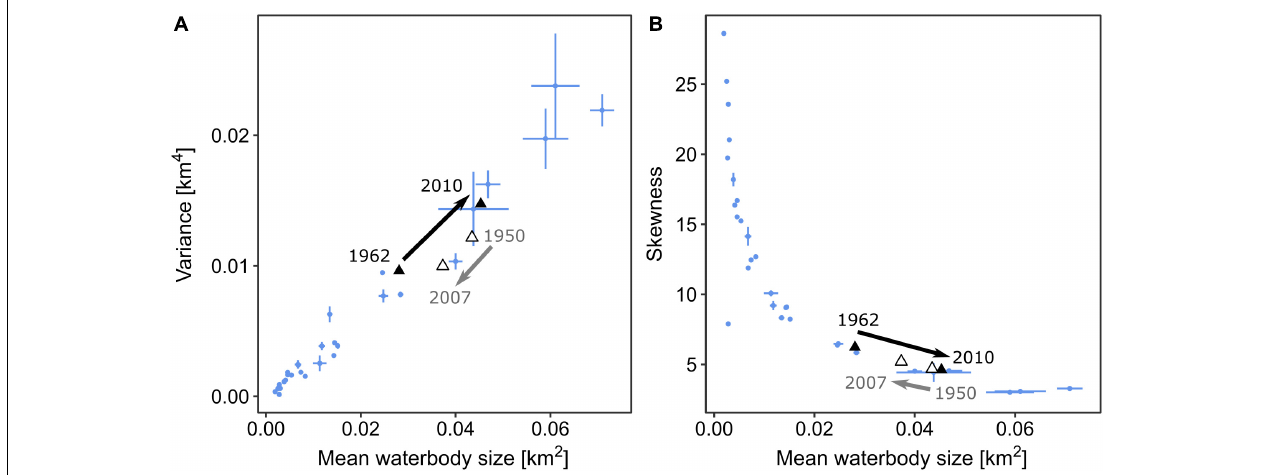
FIGURE 8 | Variations in the statistical moments of waterbody size distributions over time. The triangles and arrows indicate the development of statistical moments for the Shishmaref (black triangles: 1962–2010) and Espenberg areas (white triangles: 1950–2007) in the Kotzebue Sound Lowlands on the Seward Peninsula, for waterbody sizes between 0.001 and 1 km 2 . Blue points indicate the variance (A) and skewness (B) of the size distributions for each study region against the mean waterbody